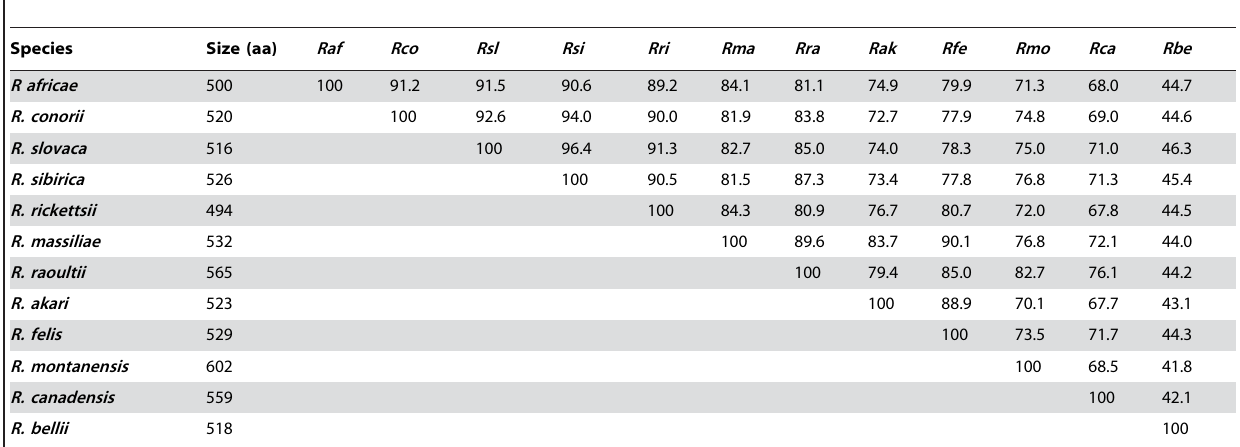
Table 1. Pairwise identity square matrix between RickA proteins from various rickettsia species.